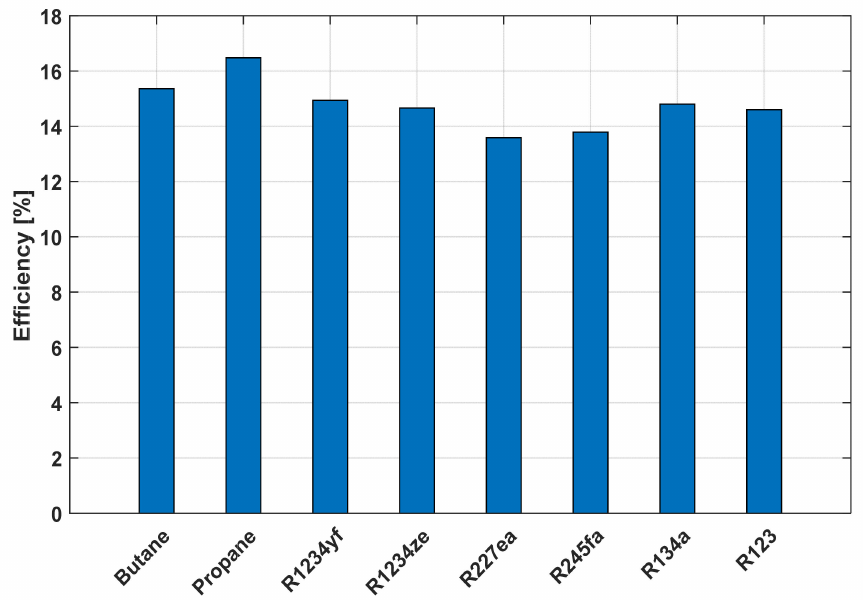
Figure 6. The efficiency of working fluids in ORC for set of condenser